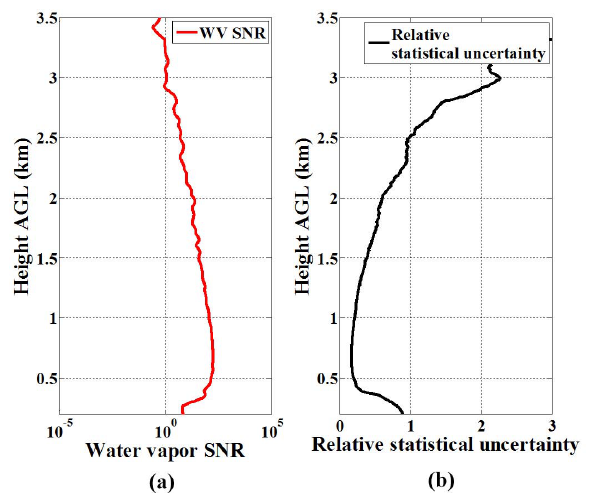
Figure 6. The SNR of water vapor Raman signal and the relative statistical uncertainty of water vapor mixing ratio at nighttime of 15 July